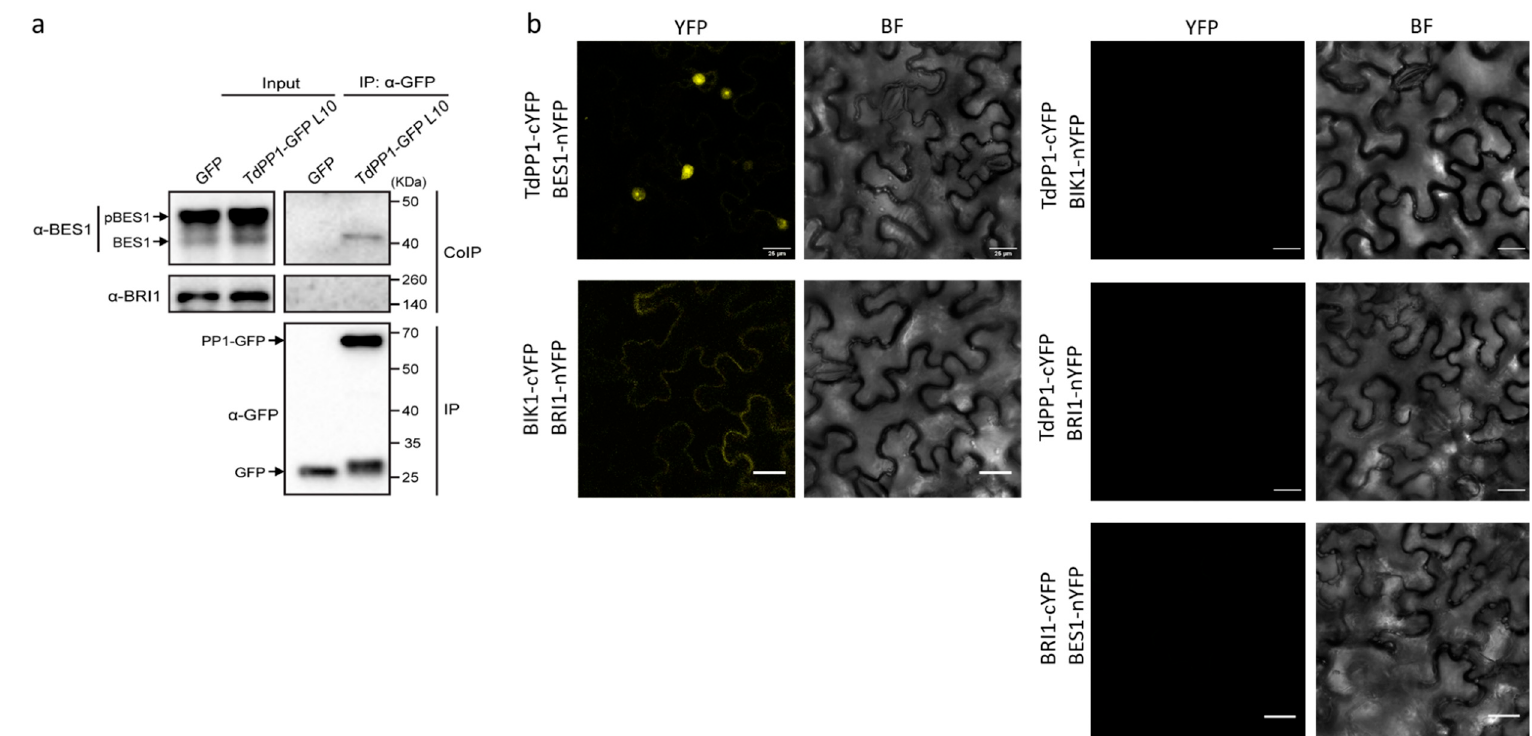
Figure 5. TdPP1 binds to unphosphorylated BES1. ( a ) TdPP1 co-immunoprecipitates with BES1 but not with BRI1. Total proteins were extracted from TdPP1-GFP L10 and 35S::GFP transgenic line as negative control. The protein extracts were immunoprecipitated using anti-GFP Trap beads. Total (input), immunoprecipitated (IP) and co-immunoprecipitated (CoIP) proteins were analyzed by immunoblotting. GFP was used as a negative control for Co-IP. TdPP1-GFP and GFP were detected with anti-GFP antibody ( α -GFP), BES1 with anti-BES1 ( α -BES1) antibody and BRI1 with anti-BRI1 ( α -BRI1). The upper arrow indicates the band of the phosphorylated BES1 (pBES1), and the lower arrow indicates the band of dephosphorylated BES1 (BES1). ( b ) TdPP1 interacts with BES1 and not with BRI1 in Nicotiana benthamiana . N.benthamiana leaves were co-agroinfiltrated with Agrobacterium strains expressing TdPP1 protein fused to the C-terminus half of YFP and BES1 or BRI1 proteins fused to the N-terminus half of YFP and observed with confocal microscopy. Images show YFP fluorescence in yellow (YFP) and cells in bright field (BF). The proper expression of BRI1 was confirmed by positive interaction monitored as a fluorescence signal emitted by interaction between BRI1 and BIK1. Scale bars represent 25 µm.